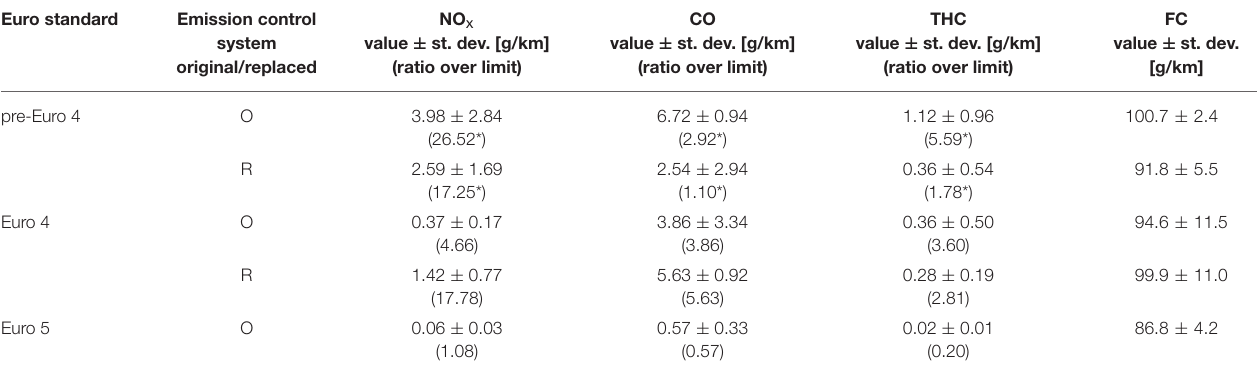
TABLE 1 | Average emission and fuel consumption levels ± standard deviation, and respective ratio over Euro standard